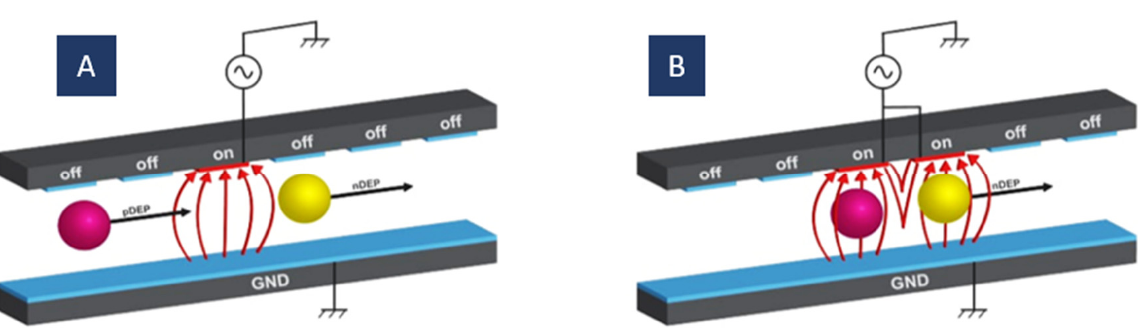
Figure 9. The moving DEP (mDEP) principle for particle manipulation; ( A ) the particles are attracted to the actuated electrode (pDEP) or repelled from it (nDEP); ( B ) particles that experienced pDEP stay in their place while particles that experienced nDEP move to the next activated electrode.